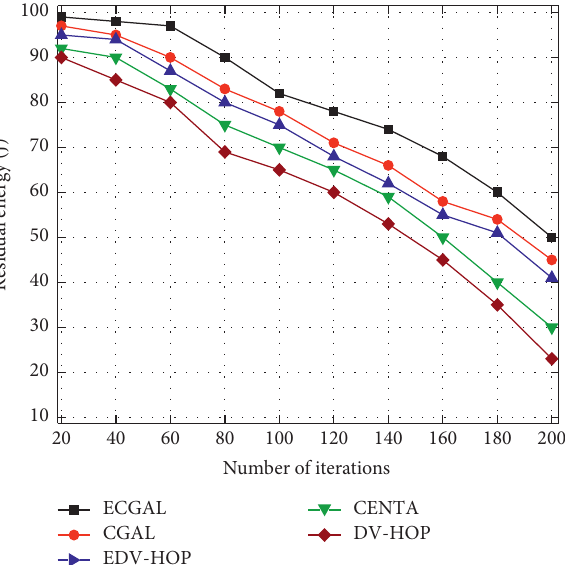
Figure 14: Residual energy against the number of iterations.